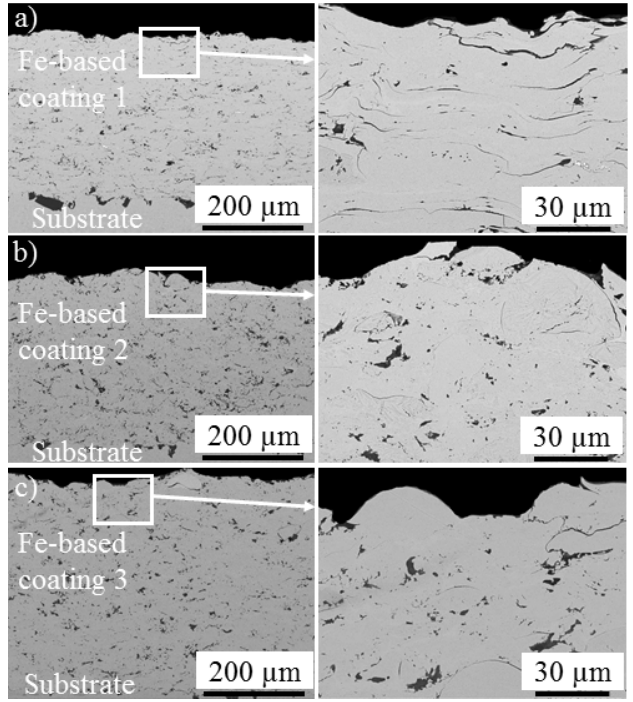
Figure 4. Back ‐ scattered SEM micrographs of cross ‐ sections of as ‐ sprayed ( a ) Fe ‐ based 1, ( b ) Fe ‐ based 2 and ( c ) Fe ‐ based 3. Figure 4. Back-scattered SEM micrographs of cross-sections of as-sprayed ( a ) Fe-based 1, ( b ) Fe-based 2 and ( c ) Fe-based